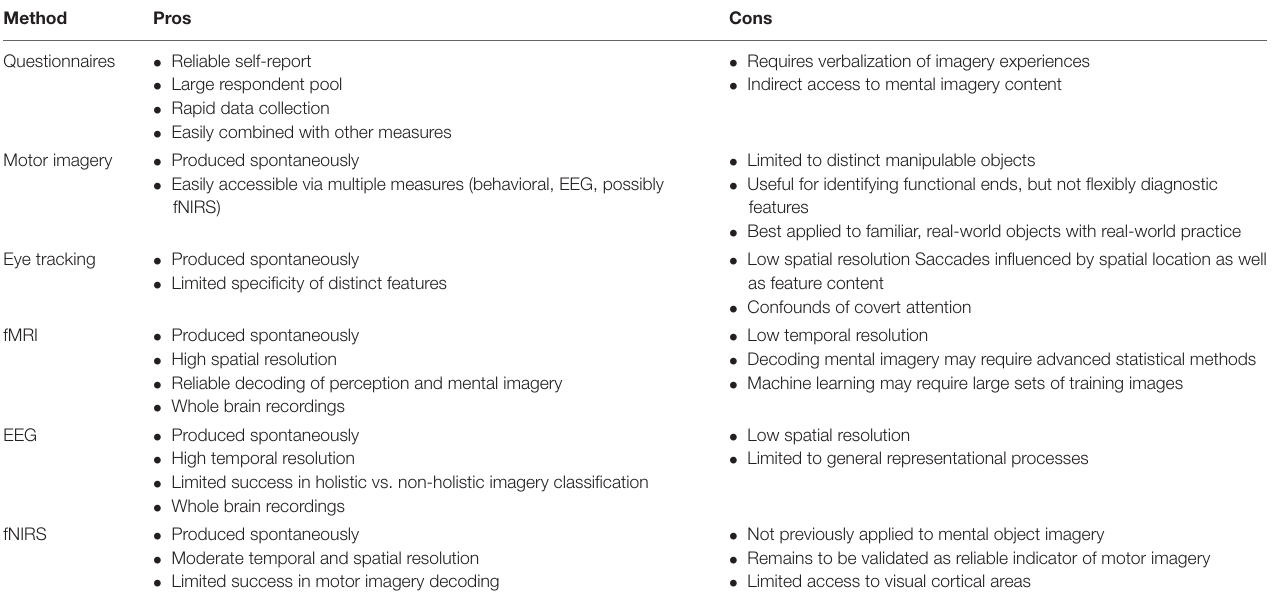
TABLE 1 | Methodological pros and cons for accessing object mental imagery